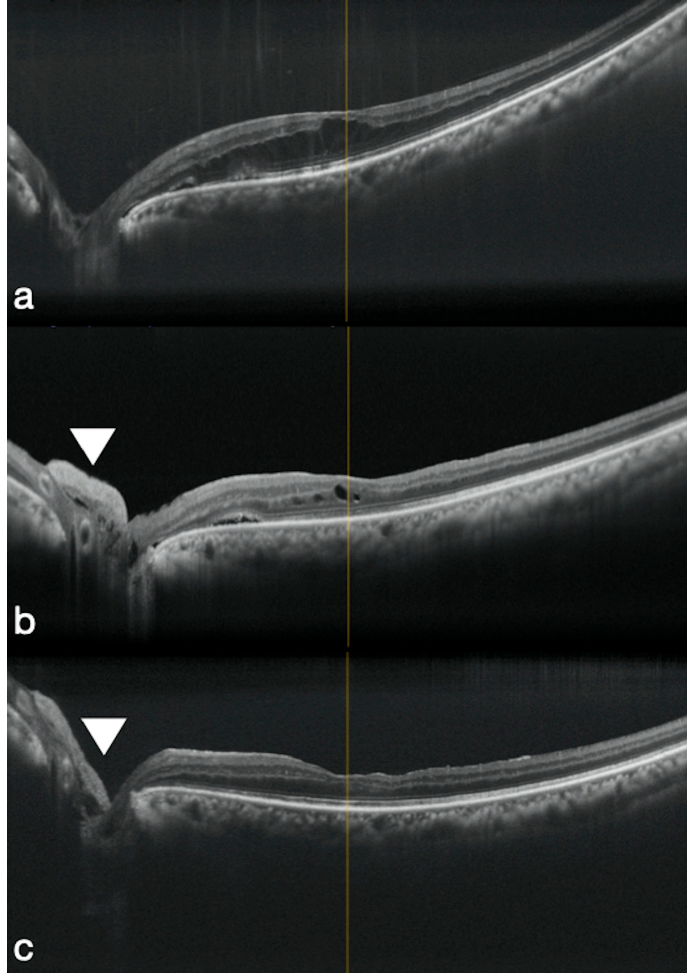
Figure 2. Preoperative OCT shows an optic disc pit maculopathy ( a ). 1 and 3 months postoperative OCT shows the hAM patch positioned inside the optic disc area (white arrows) and the macular schisis completely solved ( b,c ).